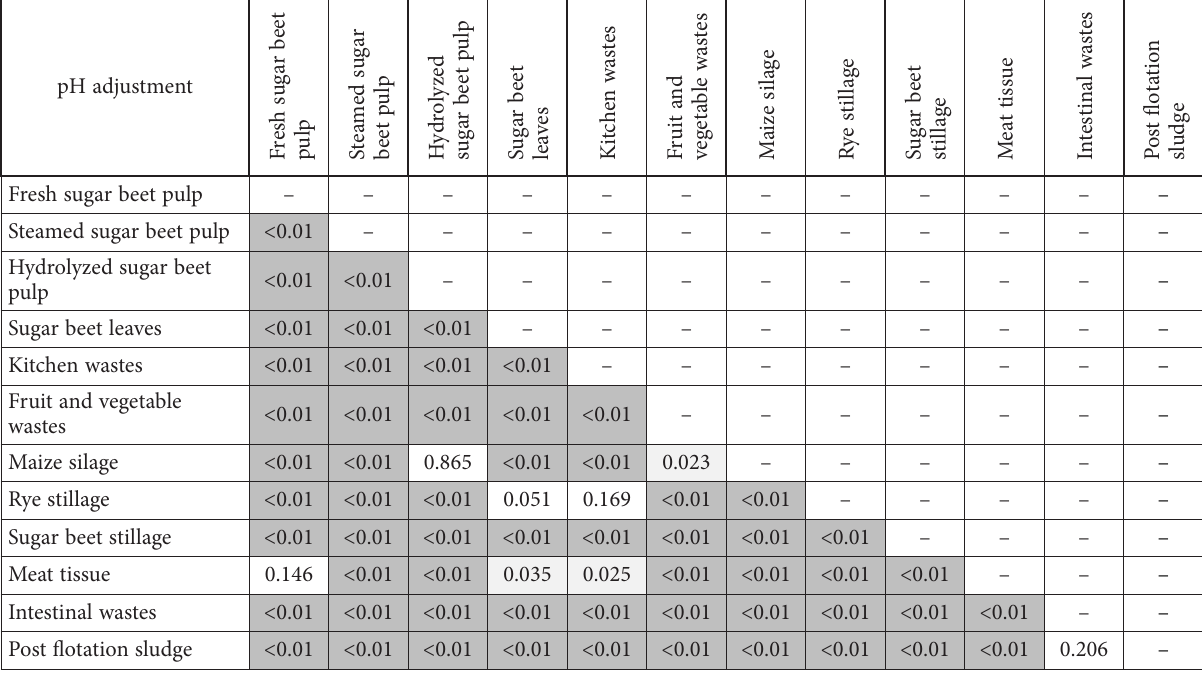
Table 2S. Statistical comparison of hydrogen production from batch test with pH adjustment (ANOVA, p value, Tukey ’ s test)